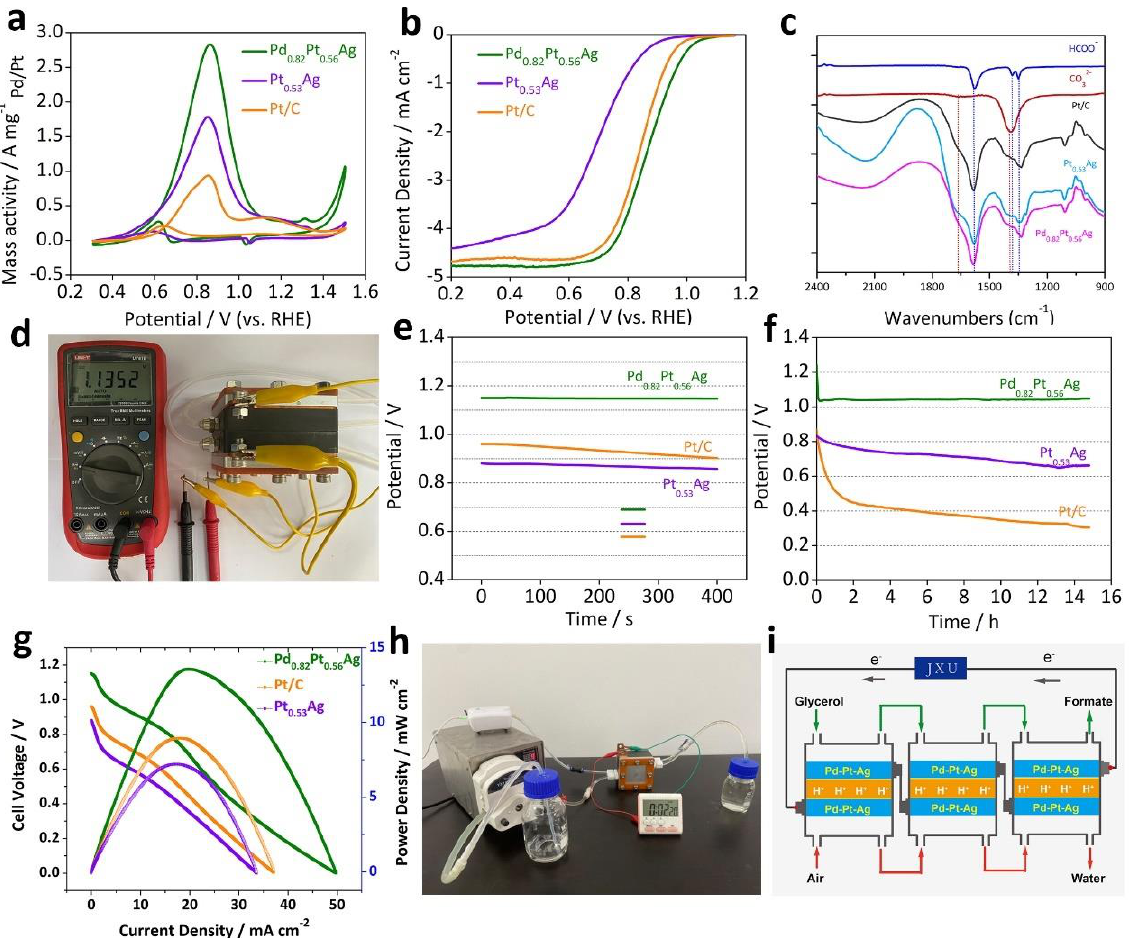
Figure 9. ( a ) CV and ( b ) LSV curves to characterize glycerol electrooxidation and ORR activity, respectively. ( c ) In situ FT−IR spectra of GOR. ( d ) Photograph displaying the V OCP value measured with a multimeter. ( e ) V OCP values of the DGFCs evaluated with a battery testing system. ( f ) Discharging curves of DGFCs at a constant current of 500 μA. ( g ) Polarization and power density curves of the cell. ( h ) Photograph showing the timer powered by a single DGFC. ( i ) Schematic diagram of energy flow and mass transportation. Reproduced with permission [32], Copyright 2022, RSC Publishing Group.